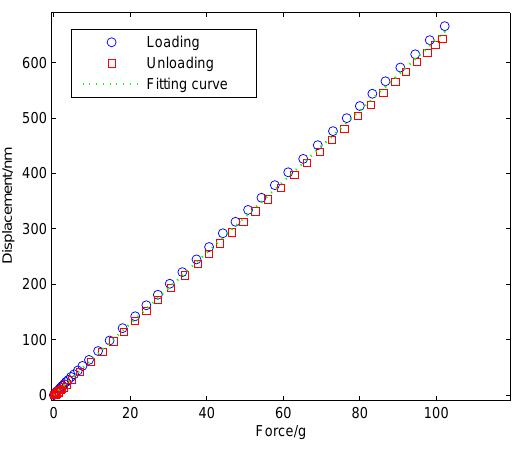
Figure 8. Calibration results of the sensing module.